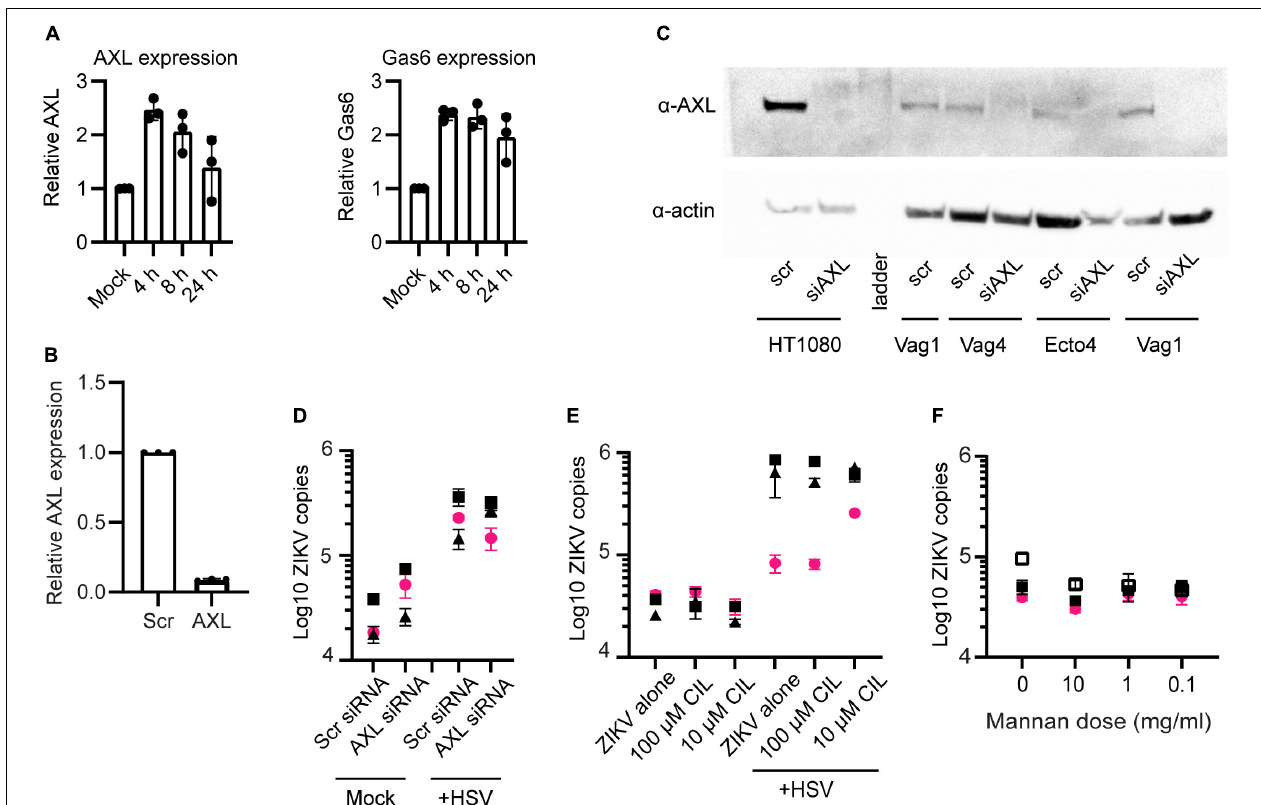
FIGURE 3 | AXL is not essential for ZIKV binding. (A) Real-time qPCR analysis of AXL and Gas6 mRNA expression post HSV-2 infection. Y -axis shows fold variation relative to mock-infected controls. Gene expression was normalized by RPP30. (B) qPCR analysis of AXL mRNA 24 h after knock down by siRNA. Epithelial cells were transfected with a scrambled siRNA (10 nM) or with 3 different siRNAs targeting AXL mRNA (10 nM, each). Lipofectamine 3000 and Trifecta kit (IDT Technologies) was used for the transfection. Data were normalized by RPP30 levels. Data show results from 3 independent experiments done in 3 different cell lines, averaged from 2 technical replicates. (C) Western blotting analysis of AXL siRNA knock down. Top: anti-AXL ( α AXL; bottom; anti-Actin ( α Actin). “scr”: scrambled siRNA, used as negative control. “Vag” are vaginal cell lines and “Ecto” is ectocervical. (D) ZIKV binding was not affected by AXL knock down. After 72 h of AXL siRNA (or scrambled siRNA) and 24 h post HSV-2 (or mock-treated), cells were exposed to ZIKV for 1.5 h and binding was evaluated by RT-PCR. The figure shows three independent experiments. For (D–F) , each symbol is a different cell line and colors indicate tissue of origin: vaginal in black and ectocervical in pink. (E) Cilengitide does not block ZIKV binding. Uninfected or HSV-2 infected cells were treated with the RGD binding motif blocking drug cilengitide at indicated concentrations for 1 h at 37 ◦ C prior to adding ZIKV for 1.5 h. Binding was evaluated by RT-qPCR, results shown from 3 independent experiments. (F) Mannan does not block ZIKV binding to cells. Uninfected cells were incubated with the indicated dose of mannan for 1 h at 37 ◦ C prior to adding ZIKV for 1.5 h. Binding was evaluated by RT-qPCR, results shown from 3 independent